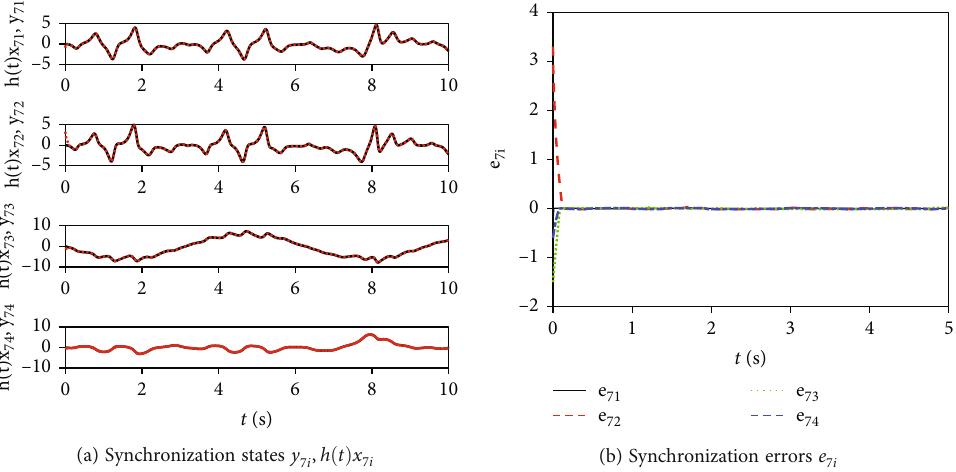
Figure 14: The time evolution of synchronization between y